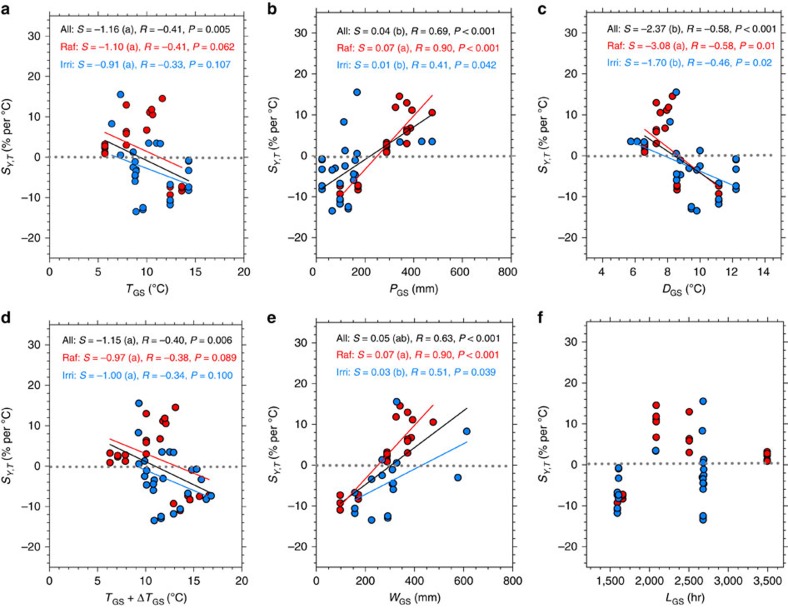
Relationships between SY,T and background climate variables for the field warming experiments.(a) growing-season temperature (TGS). (b) Growing-season precipitation (PGS). (c) Growing-season diurnal temperature range (DGS). (d) Growing-season increased temperature (TGS+ΔT). (e) Growing-season water supply (WGS; precipitation+irrigation). (f) Growing-season daylight hours (LGS). The data points are grouped into three categories: all included (All; black), rainfed (Raf; red) and irrigated (Irri; blue). S represents the slope of the regression line. The same letter (for example, a) in the bracket indicates no significant differences (P>0.05) between those categories.